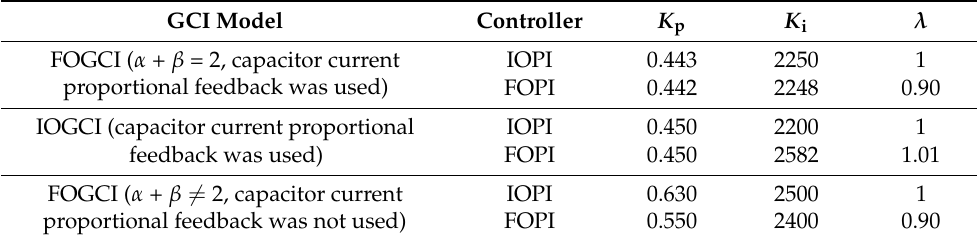
Table 4. Controller parameters.